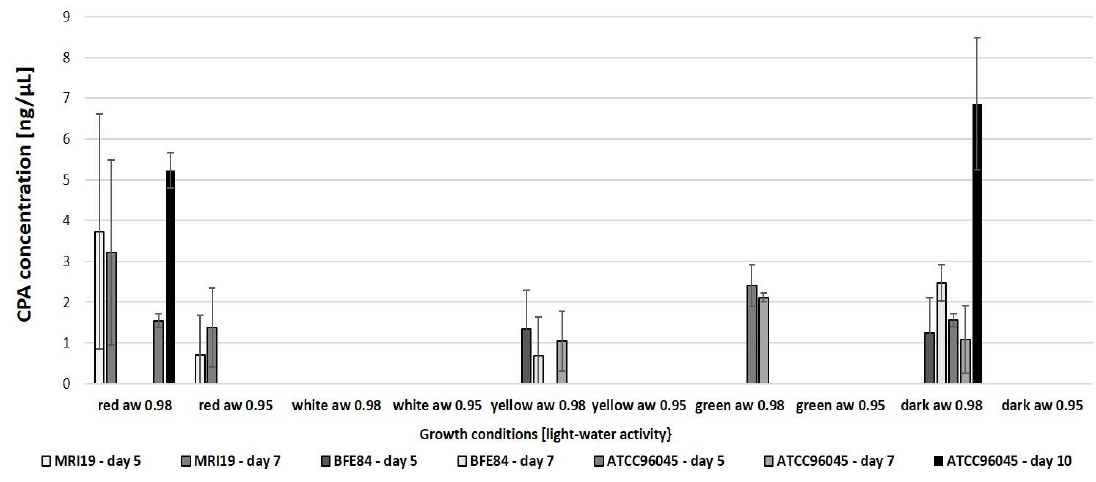
Figure 4. Cyclopiazonic Acid (CPA) formation in the analyzed Aspergillus isolates, dependent on different combinations of light and water activity. No CPA was detectable on day 10 by MRI19 and BFE84 under white light at a w 0.98, a w 0.95 and green light at a w 0.95 and blue/royal blue light. Standard deviations are given for each parameter. The measured values were too low for statistical significance analysis.